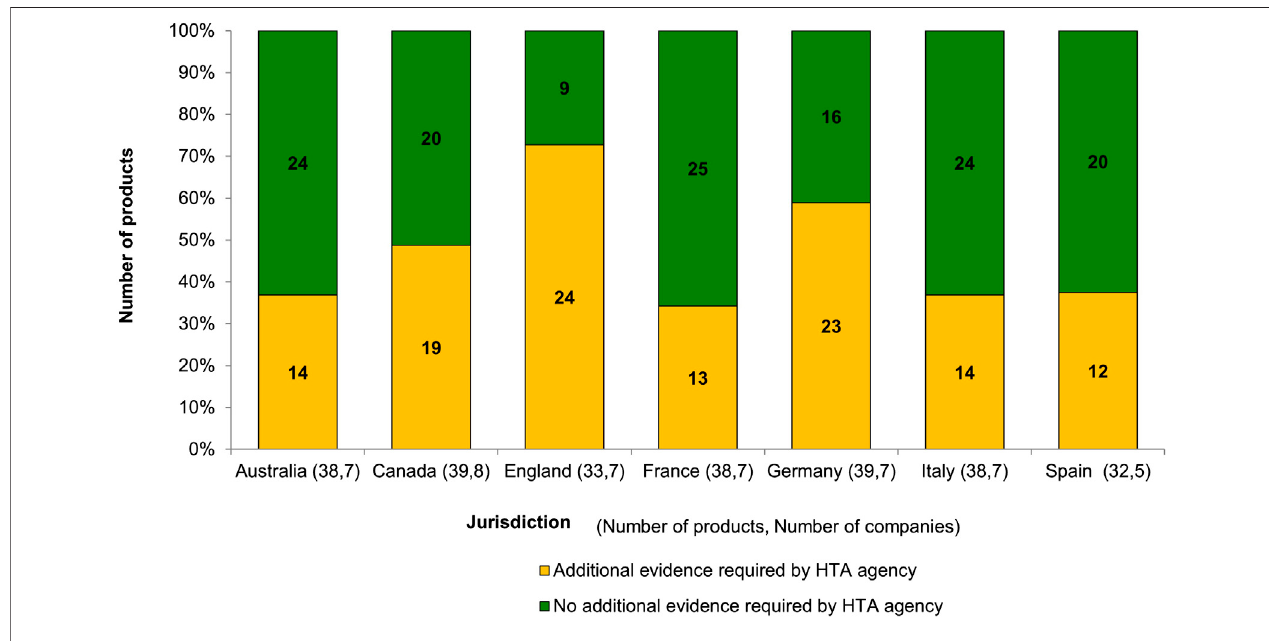
FIGURE 2 | Proportion of companies ’ submissions where additional evidence were